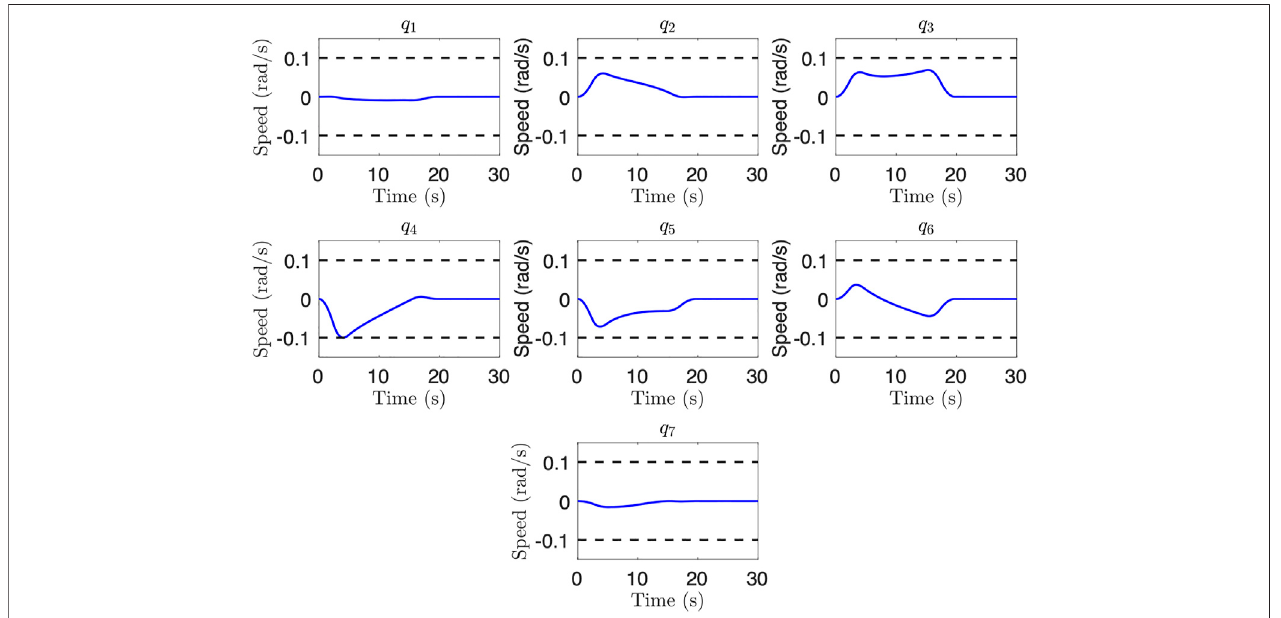
FIGURE8| Jointspeedsforanuncontrolled fl oatingbasescenarioafteroptimizationwherejointspeedisthelimitingfactor.Notethatjoint4reachesthelowerjoint speed limit.